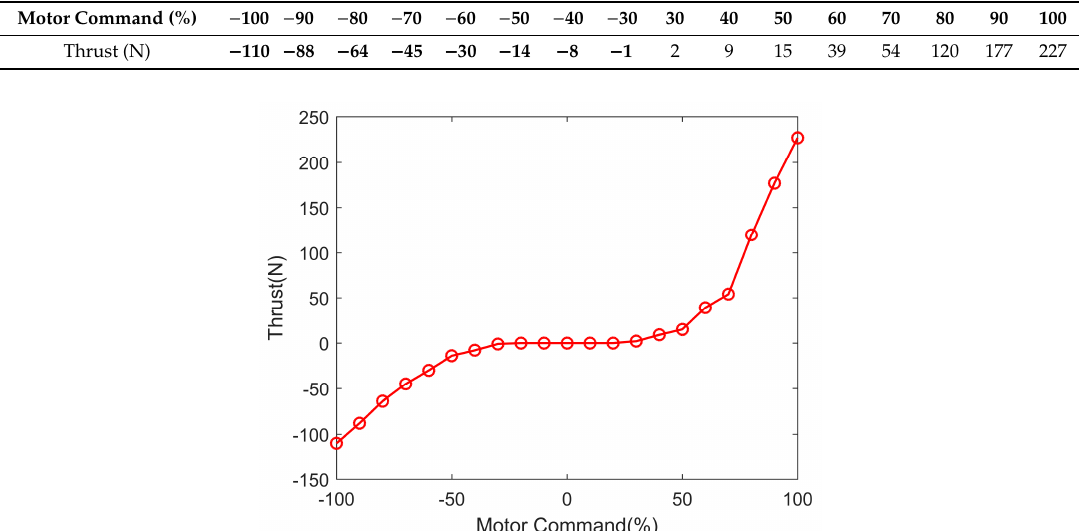
Table 2. The corresponding thrust values under di ff erent motor commands.